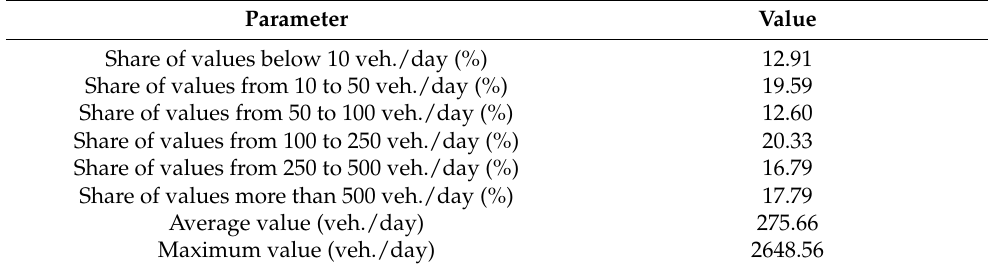
Table 4. The structure of the sample of traffic flows generated jointly by domestic and foreign trips.